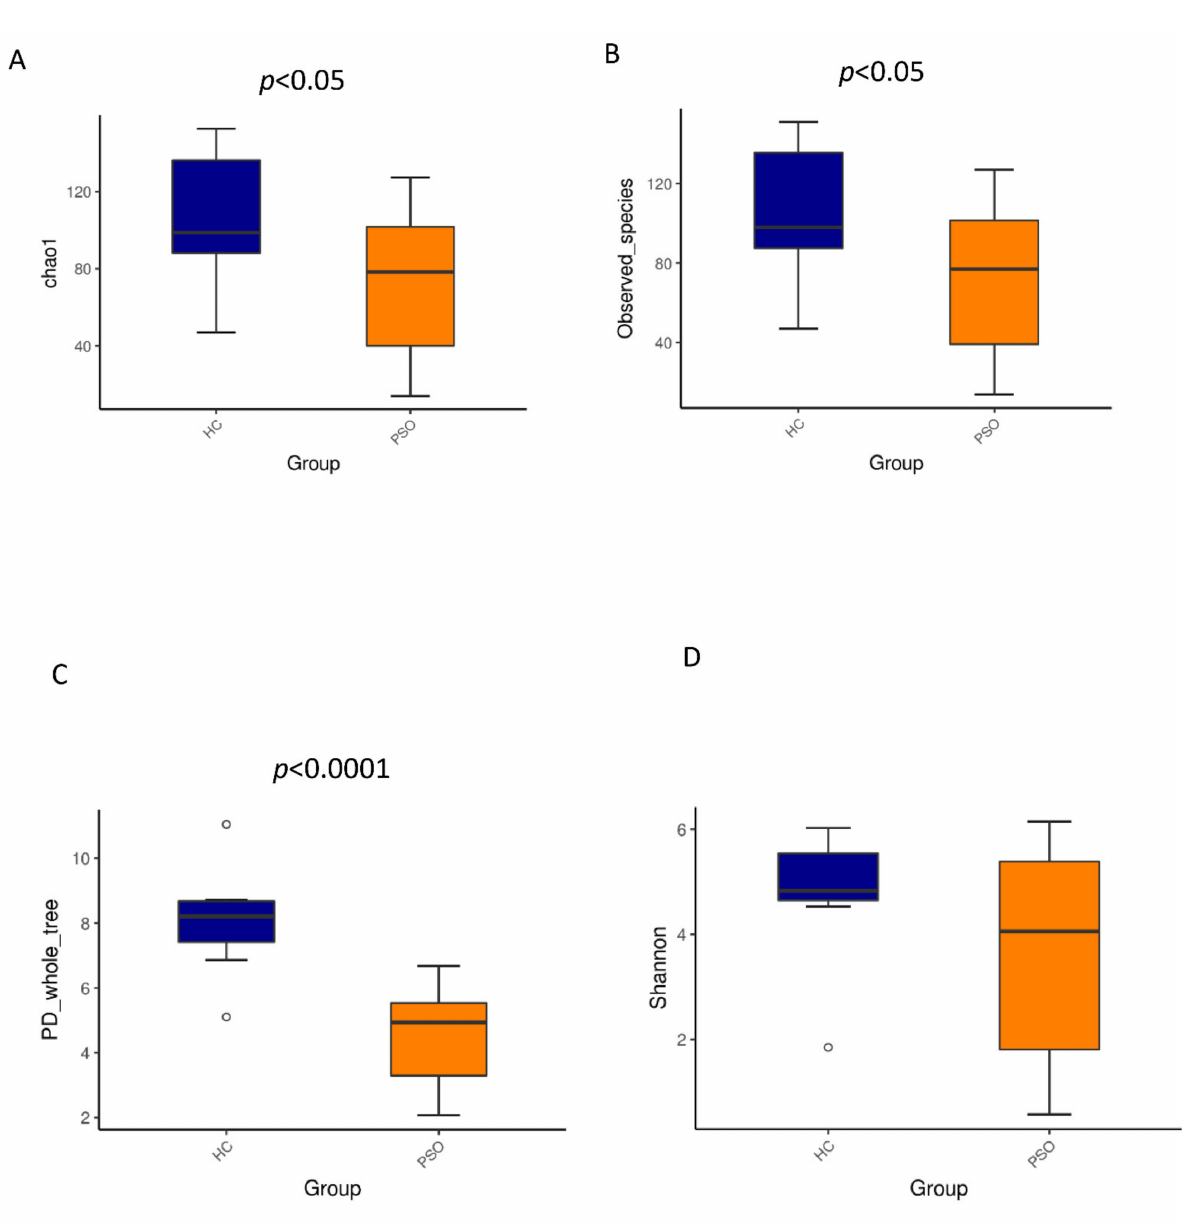
Figure 2. Alpha diversity metrics of plasma bacterial communities between healthy and psoriasis patients. Boxplots for comparison of species richness (chao1 index ( A ), observed species ( B )) between the two study groups, ( C ) boxplots for comparison of phylogenetic diversity (PD whole tree), ( D ) boxplots for comparison of species diversity (Shannon index) (HC: healthy control group; PSO: psoriasis